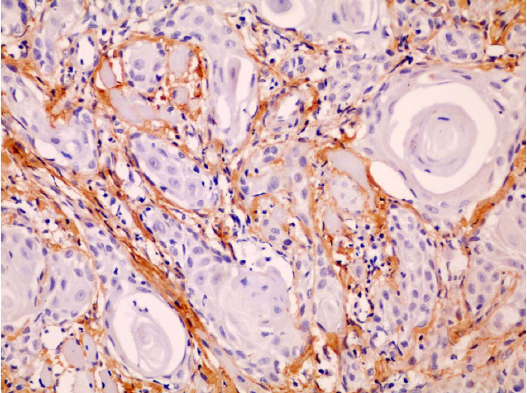
Figure 5. Immunoexpression of type I collagen in tumor stroma of SCCTo in fibrillar pattern (LSAB method, original magnification ×400).